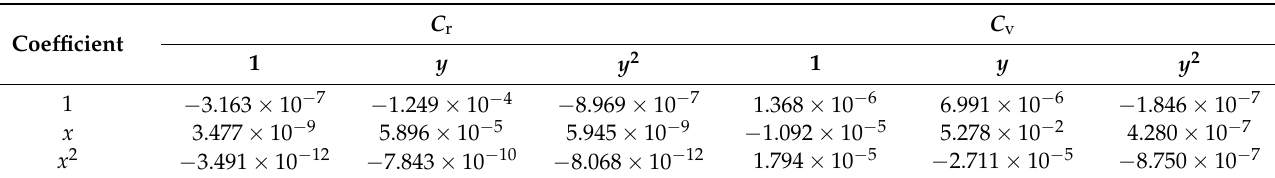
Figure 4. Standard deviation surface of relative phase deviation. Table 4. Least-squares fitting coefficient